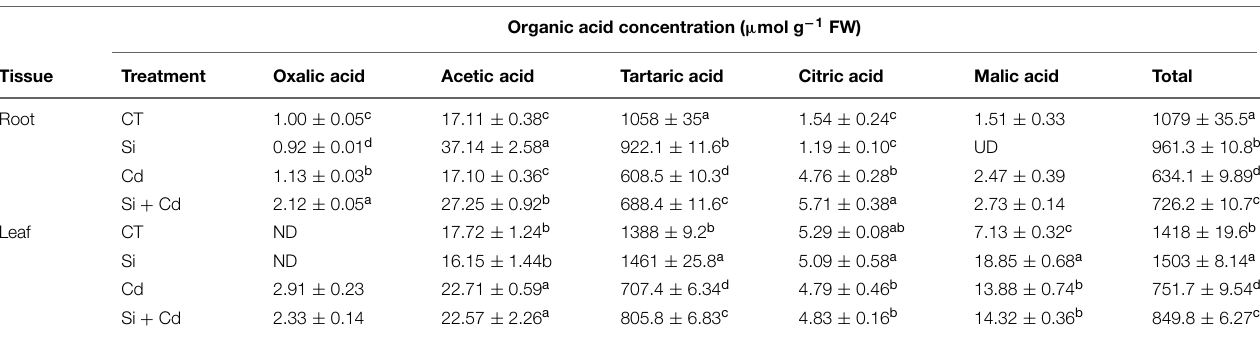
TABLE 5 | Effect of Si on organic acids concentrations in cucumber seedlings under Cd